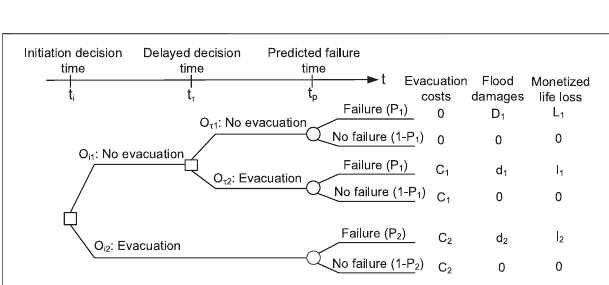
FIGURE 15 | Multi-phase decision trees for warning decision-making of dam/leveefailure.NoteD